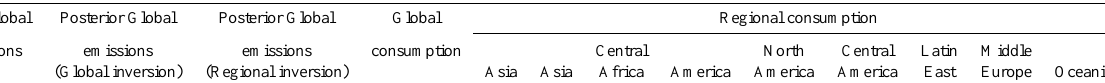
Table 2. Prior and Posterior Global Total Emissions and Annual Global/Regional Consumption of HCFC-22 (Ggyr − 1 ). Consumption data is taken from UNEP